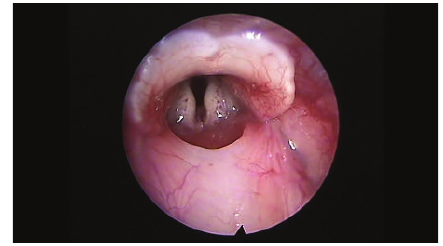
Figure 1: Normal vocal fold.